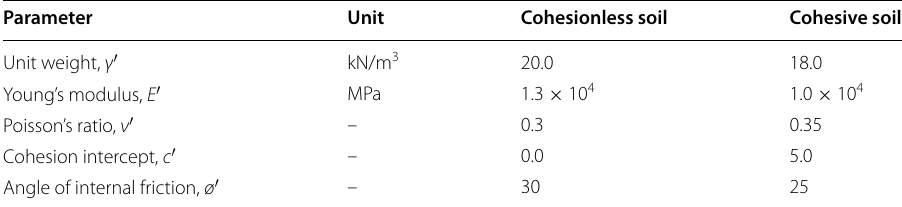
Table 1 Soil parameters for analysis of pile